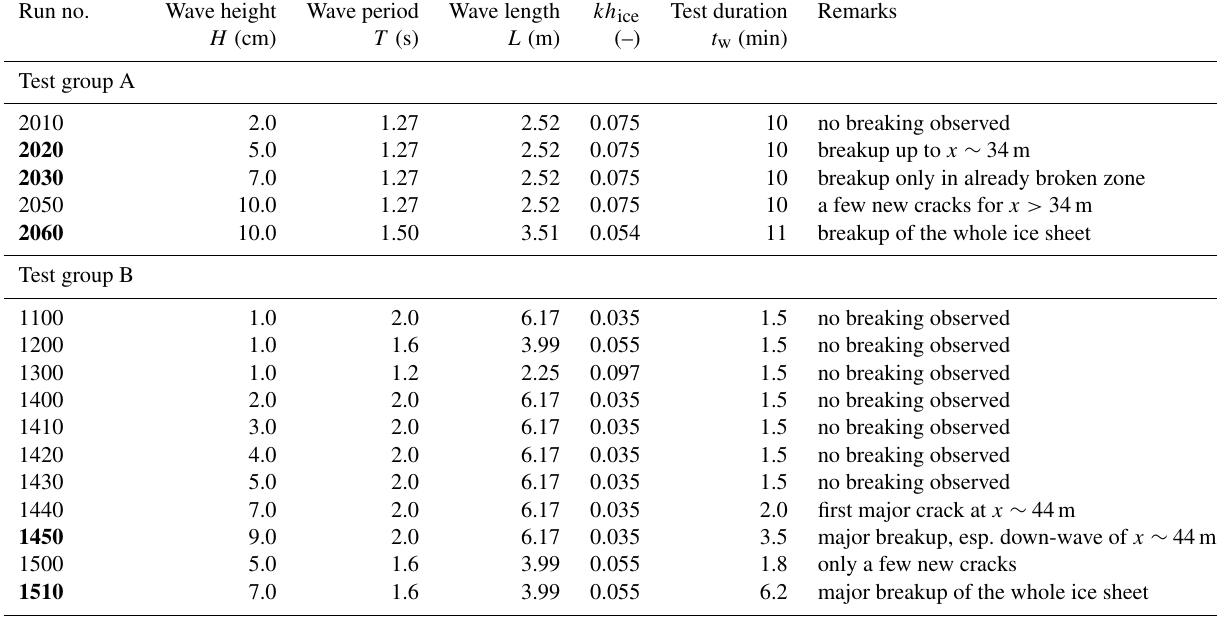
Table 1. Summary of test runs discussed in this paper. Run